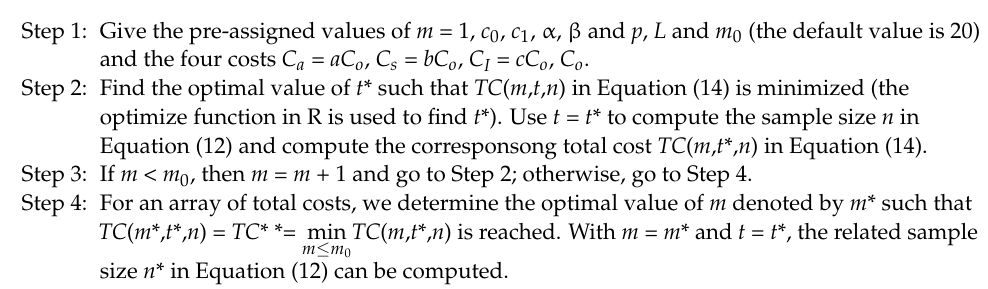
Figure 5. Minimum total cost curve for p = 0.05, 0.075, 0.1 at α = 0.1 and β = 0.25.